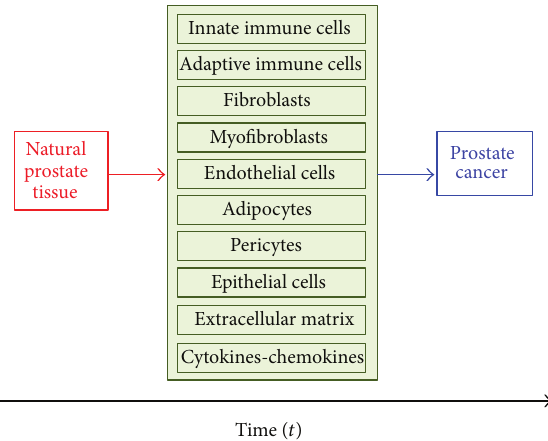
Figure 2: Histopathological examination reveals that prostate cancer is associated with diverse immune cell infiltrates and that, in the cancer context, epithelial cells coexist with extracellular matrix components and nonneoplastic cell types, including fibroblasts and endothelial cells, which collectively form the tumour stroma. Evidence supports the concept that tumour stromal cells are not merely a scaffold, but rather they influence growth, survival, and invasiveness of cancer cells, dynamically contributing to the tumour microenvironment. The interactions between epithelium and the surrounding stroma are required to maintain organ function and provide proliferative and migratory restraints that define anatomical and positional information, mediated by several growth factors, cytokines, chemokines, and extracellular matrix components. When cancer develops, transformed cells lose these constraints while stroma adapts and coevolves to support the “function” of the